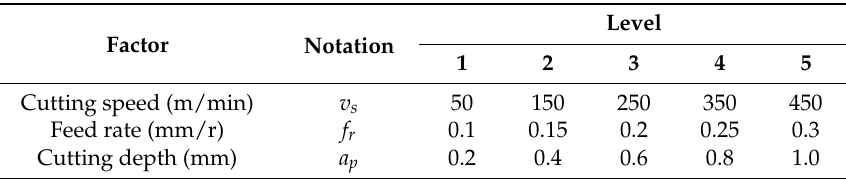
Table 5. Cutting